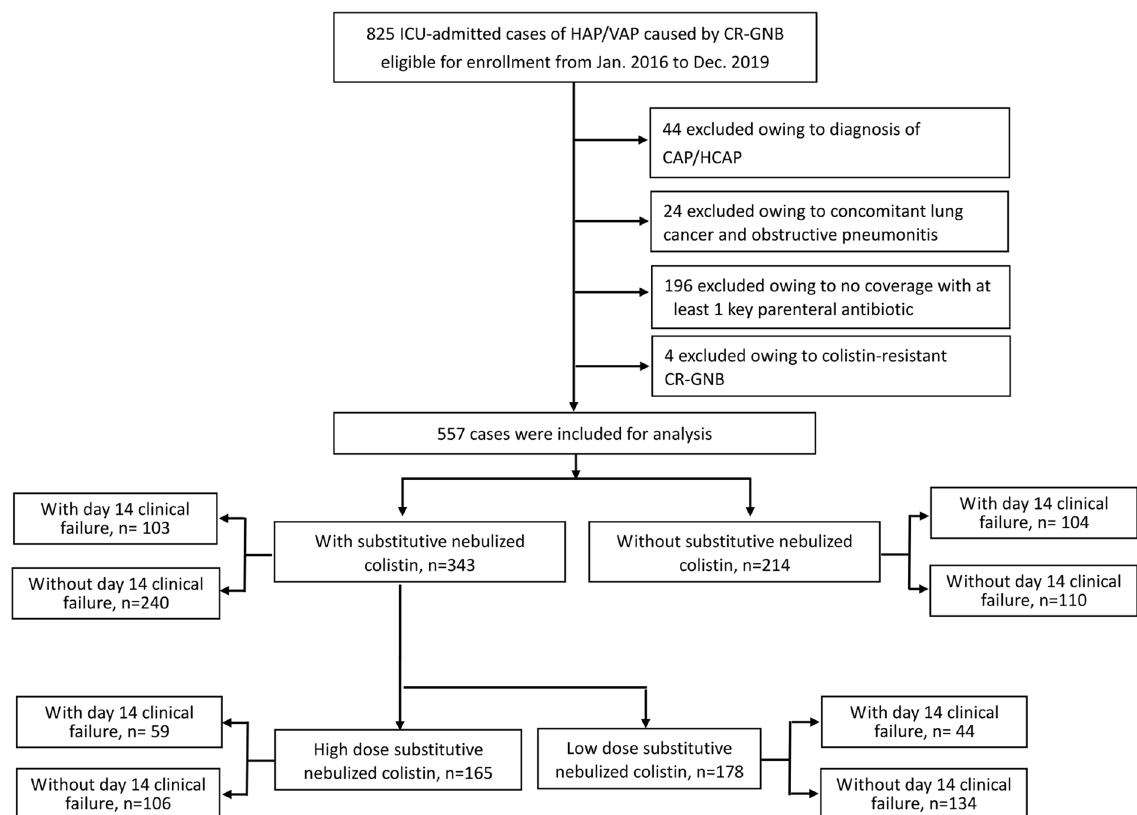
Fig. 1 Study flow diagram and patient exclusion criteria. Low dose nebulized colistin was defined as a daily dose nebulized colistin was defined as > 6 MIU CMS. CR‑GNB, carbapenem‑resistant Gram‑negative bacteria; HAP, hospital acquired pneumonia; VAP, ventilator‑associated pneumonia; ICU, intensive care